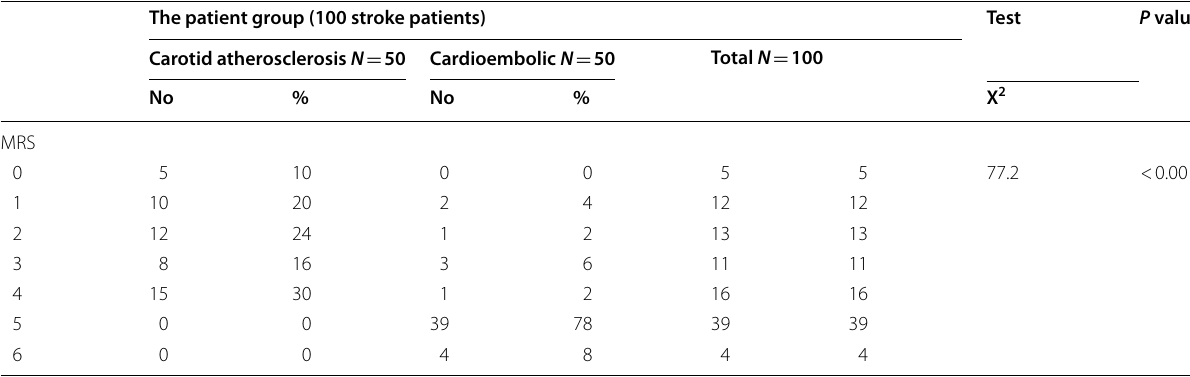
Table 6 Modified Rankin Scale (MRS) among patients group The patient group (100 stroke patients)